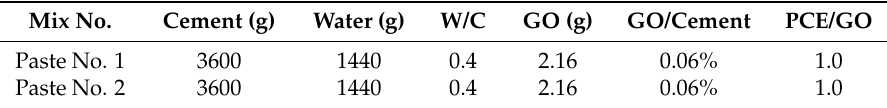
Table 4. Mix proportions of cement pastes.